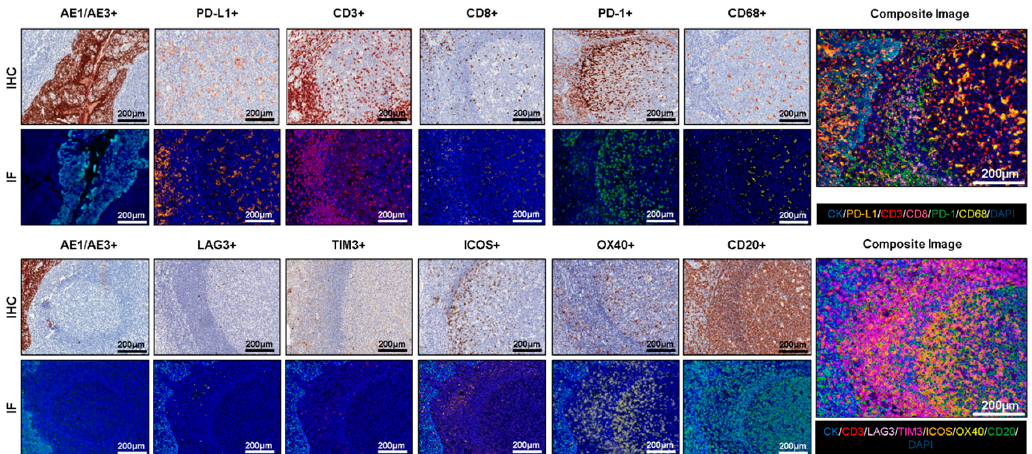
Figure 2. Antibody optimization and validation. Representative examples of antibody optimization and validation using conventional chromogenic IHC and multiplex IF showing similar patterns of expression by the antibodies tested in IHC and multiplex IF. Composite images show the integration of markers on a single slide. At 20× magnification.